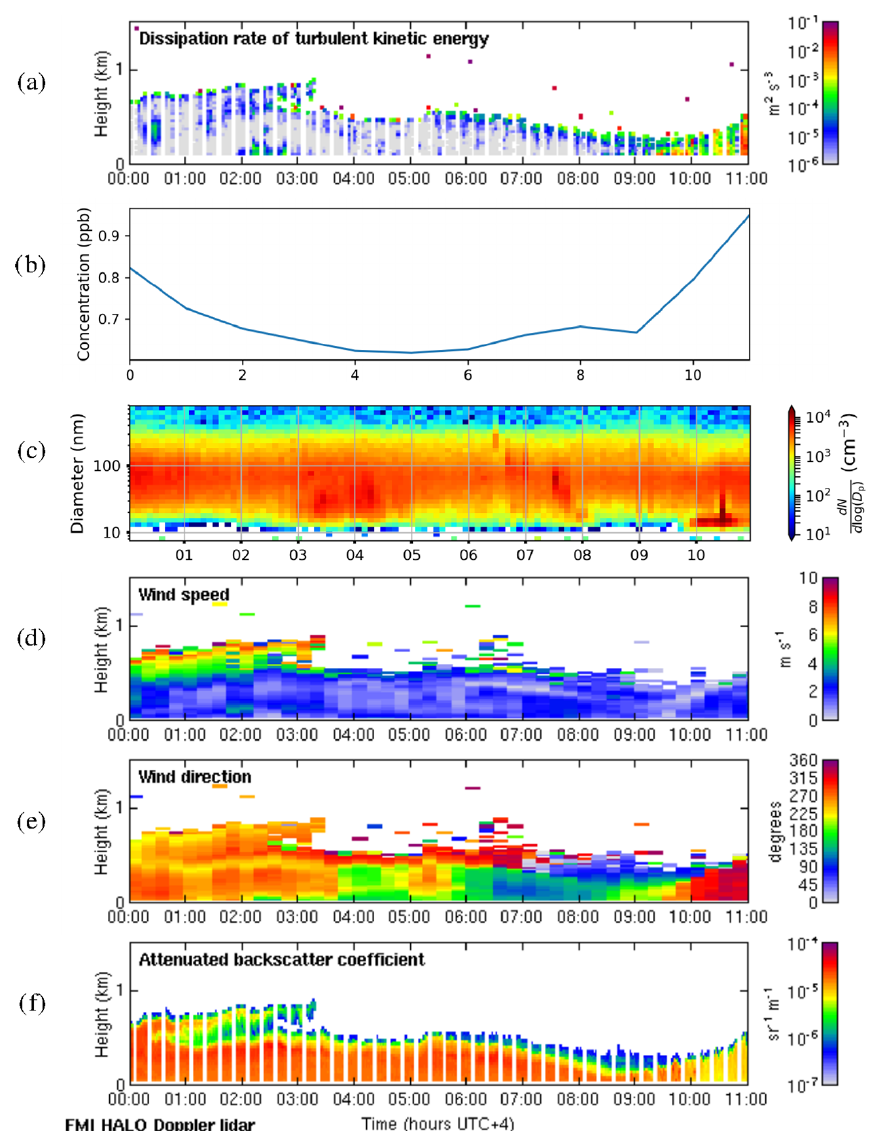
Figure C1. Shallow-boundary-layer case on 21 February 2018. (a) Time–height plot of dissipation rate of turbulent kinetic energy, (cid:15) ; (b) SO 2 concentration (ppb) measured at the surface; (c) aerosol particle size distribution measured at the surface (the colour indicates the concentration d N/ dlog( d p ) in cm − 3 ); and time–height plots of (d) wind speed, (e) wind direction, and (f) attenuated backscatter coefficient. For all panels, the time axis is local time (hours UTC + 4). The measurements in panels ( a, d, e , and f ) were obtained from the HALO Doppler